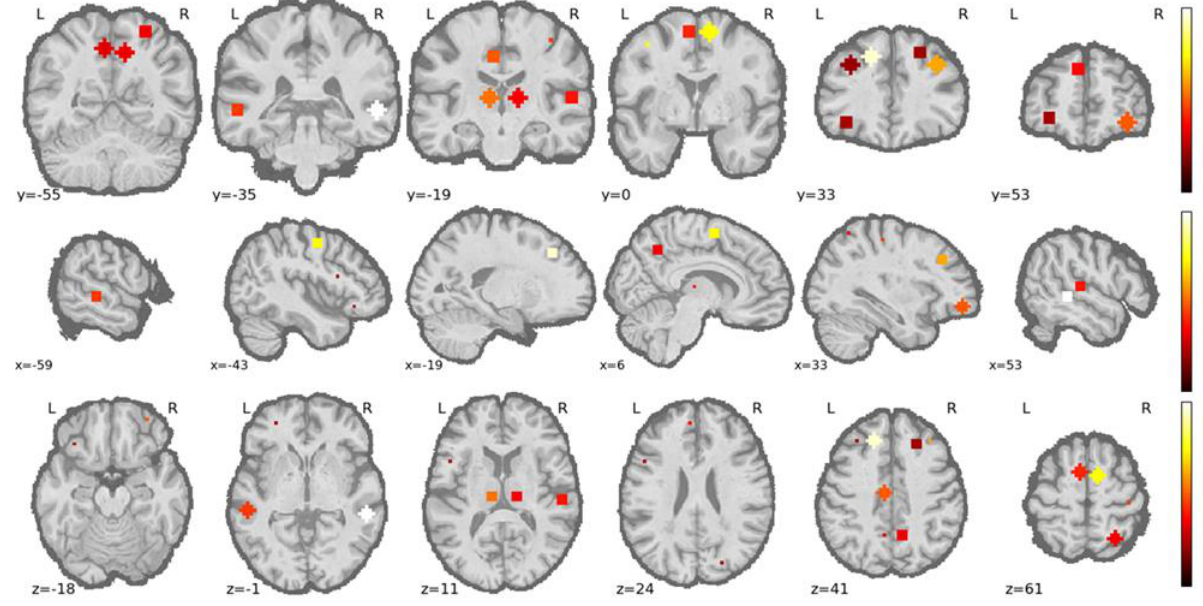
Figure 3. Brain plot for regions that are most affected during the AD progression. From top to bottom are coronal, sagittal, and axial views.